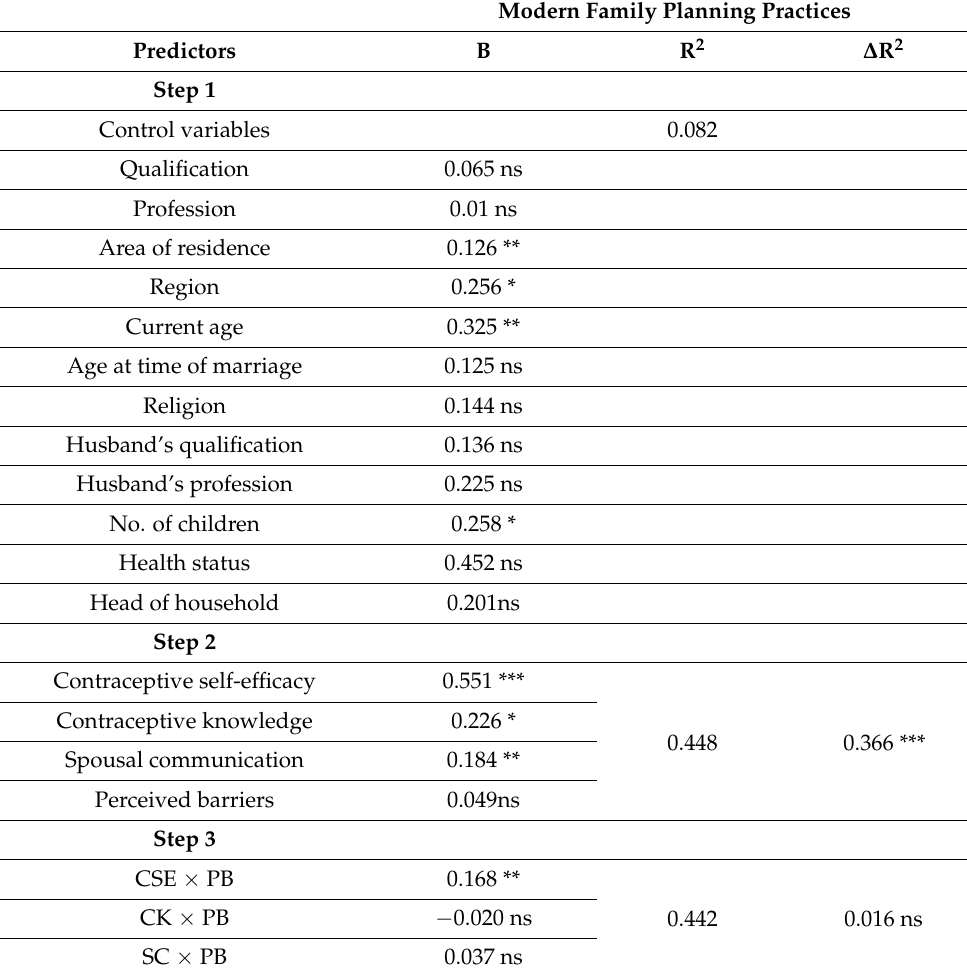
Table 4. Hierarchical moderated regression